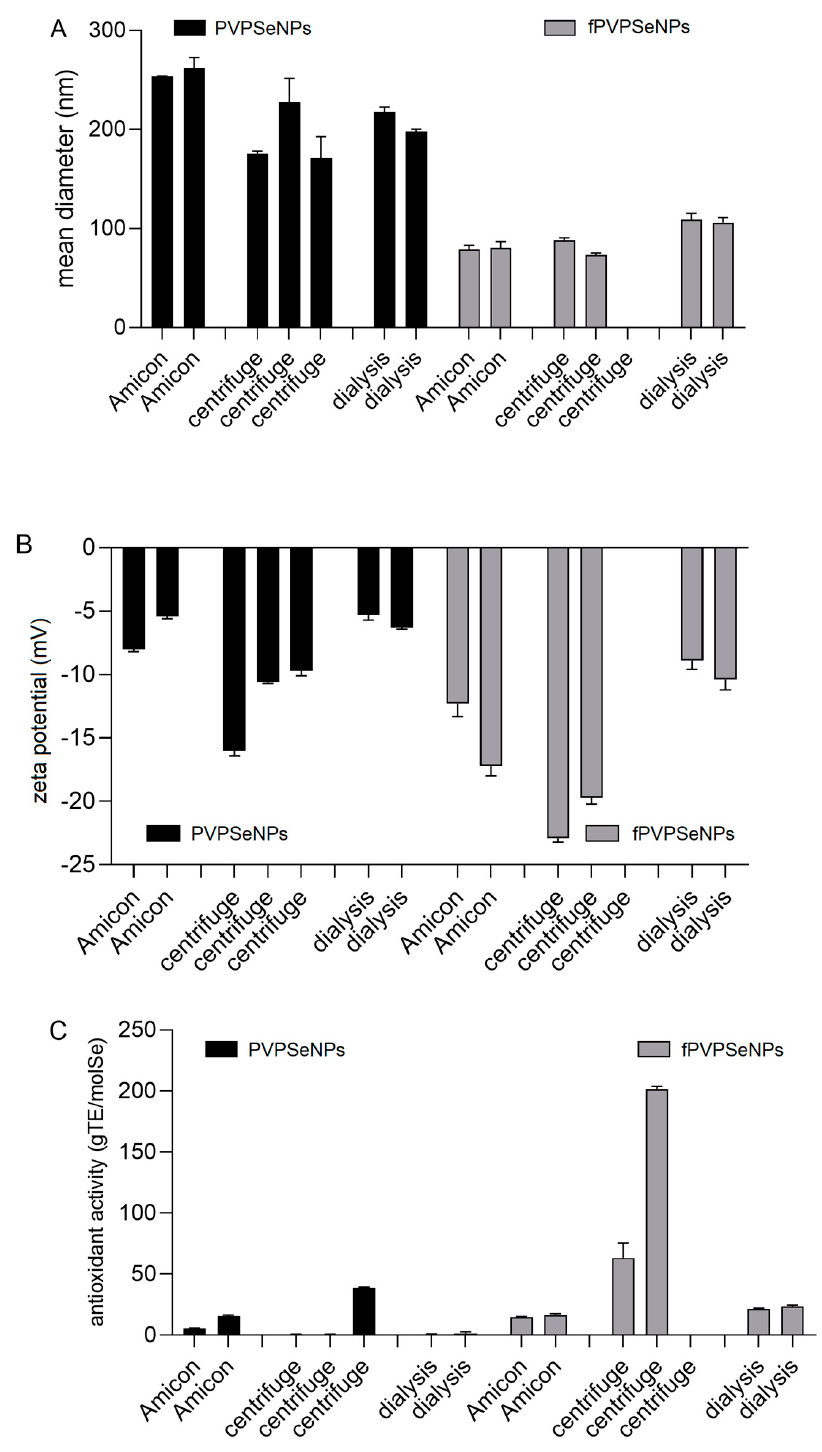
Figure 1. Impact of different separation techniques on mean hydrodynamic diameter ( A ), zeta po- tential ( B ) and Trolox-equivalent antioxidant capacity (TEAC) ( C ) of PVPSeNPs and fPVPSeNPs. (PVPSeNPs—selenium nanoparticles coated with polyvinylpyrrolidone; fPVPSeNPs—selenium nanoparticles coated with polyvinylpyrrolidone and functionalized with olive pomace extract). Multi- ple columns for same data sets indicate the number of replicates.